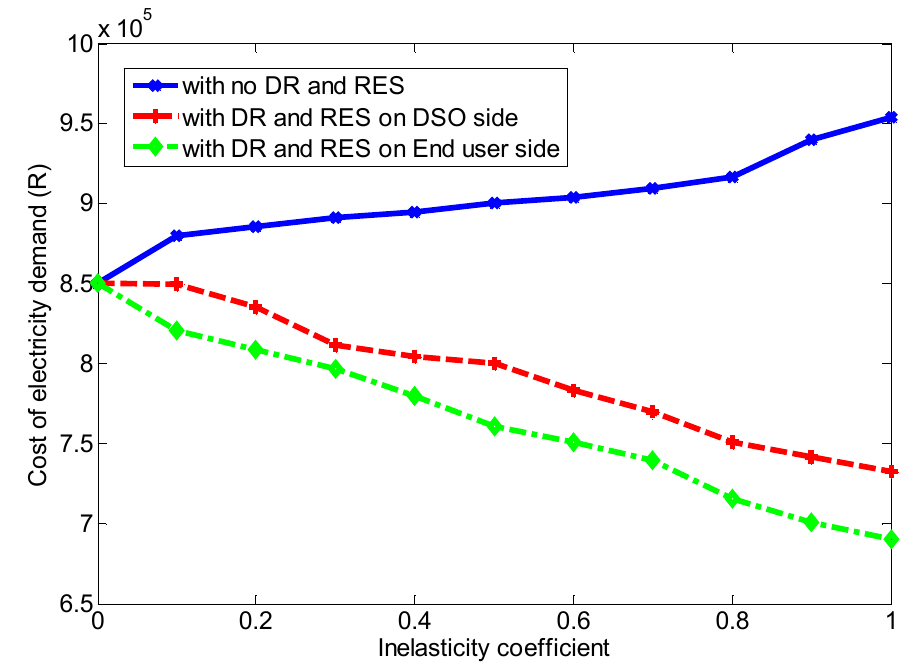
Figure 3. Comparison of cost of end user demand incurred by the DSO under various RES and DR conditions.